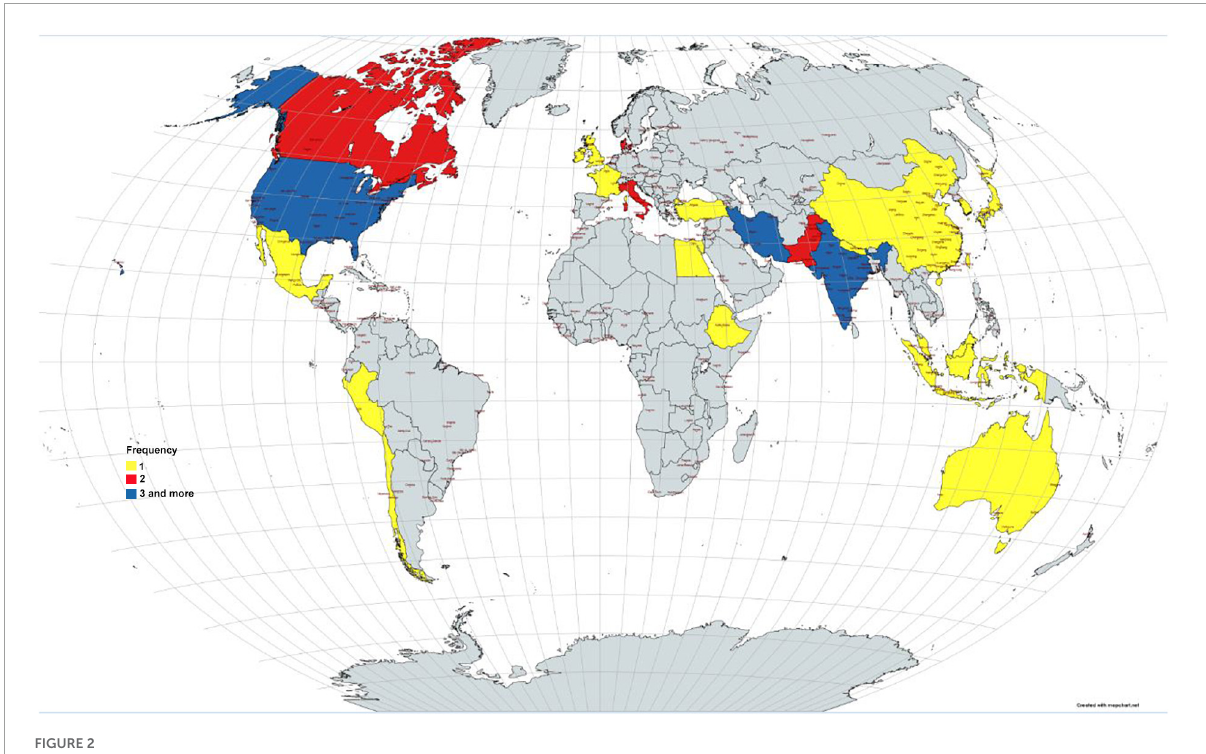
FIGURE2 Distribution of the included studies by